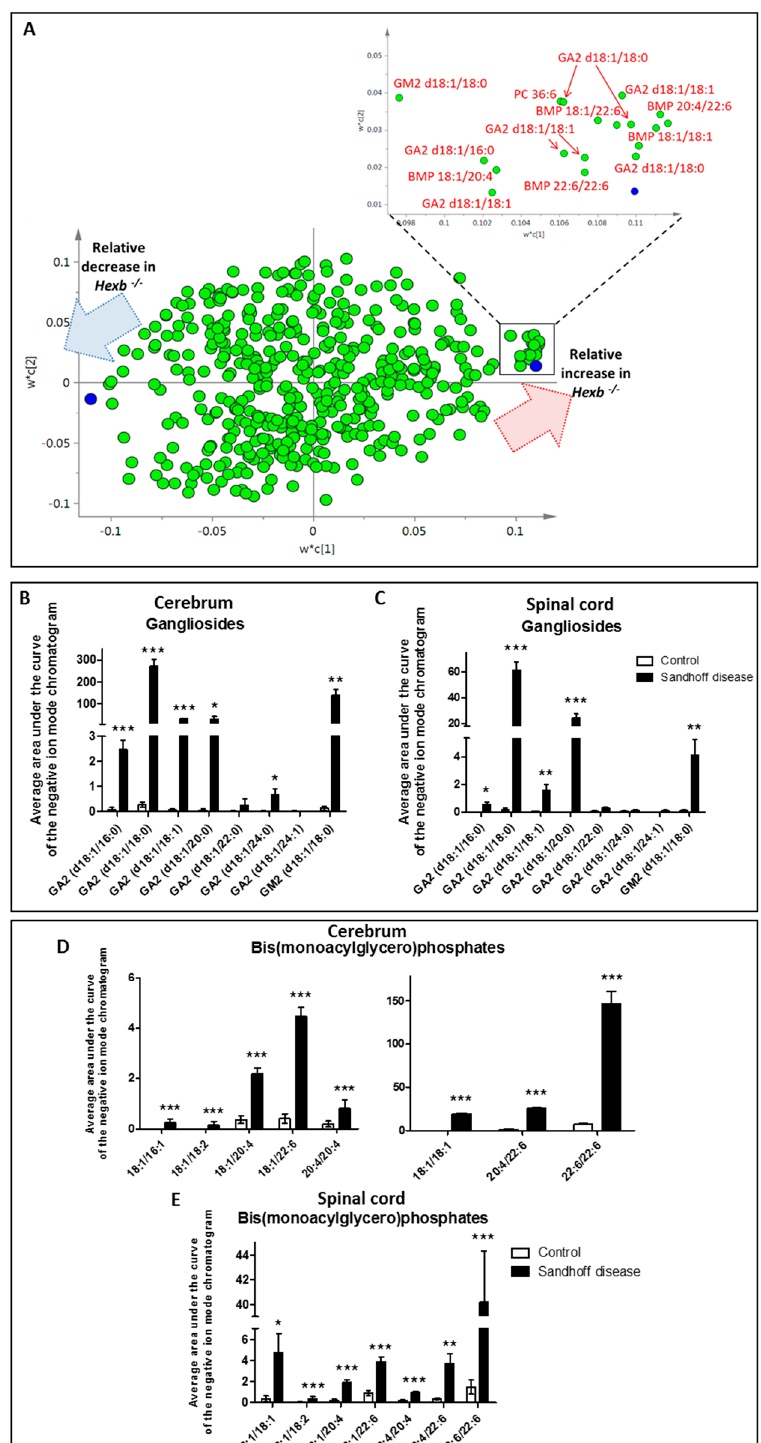
Figure 1. Metabolic variations between four-month-old Hexb − / − mice and controls detected using open profiling negative ion mode LC-MS were dominated by increases in gangliosides and bis(monoacylglycero)phosphates (BMPs). ( A ) partial least squares discriminate analysis (PLS-DA) loading scatter plot from the analysis of negative mode LC-MS of cerebrum tissue from four-month-old control and Hexb − / − mice. The most discriminatory increases in Hexb − / − mice compared to controls are labelled in red. ( B ) concentration of ganglioside species in cerebrum tissue from four-month-old control and Hexb − / − mice. ( C ) concentrations of ganglioside species in spinal cord tissue from four-month-old control and Hexb − / − mice. ( D ) concentration of BMP species in cerebrum tissue from four-month-old control and Hexb − / − mice. ( E ) BMP concentrations in spinal cord tissue from four-month-old control and Hexb − / − mice. Results are presented as mean +/ − SEM. Significance level quoted for Student’s t -test * p ≤ 0.05; ** p ≤ 0.01; *** p ≤ 0.001.